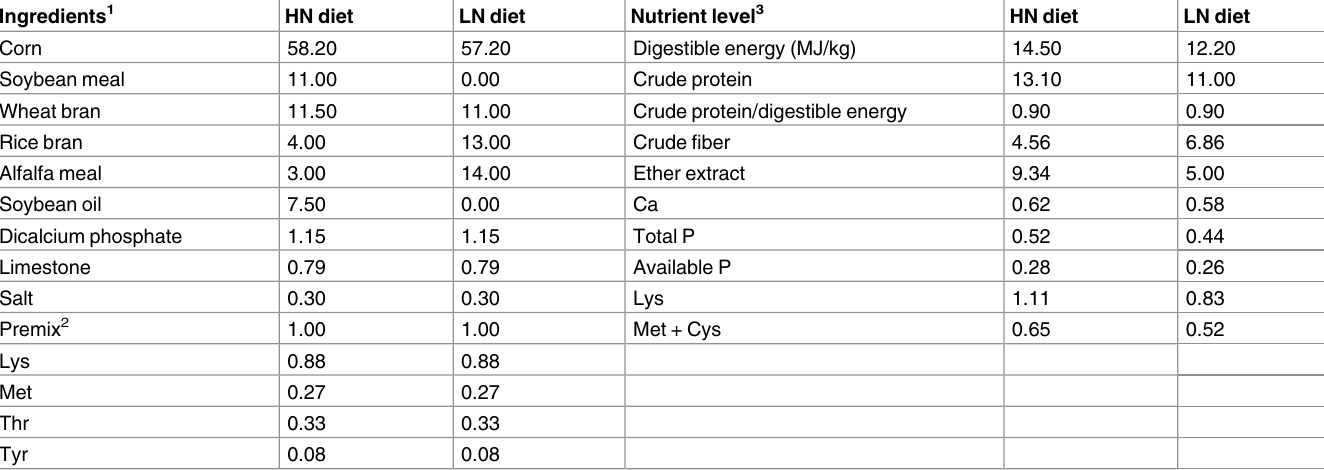
Table 1. Ingredients and nutritional composition of the two experimental diets (air-dried basis,